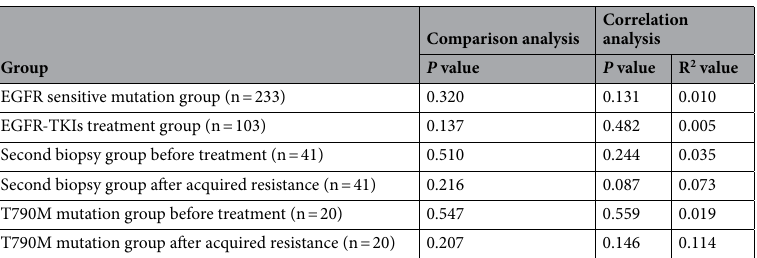
Correlation analysis